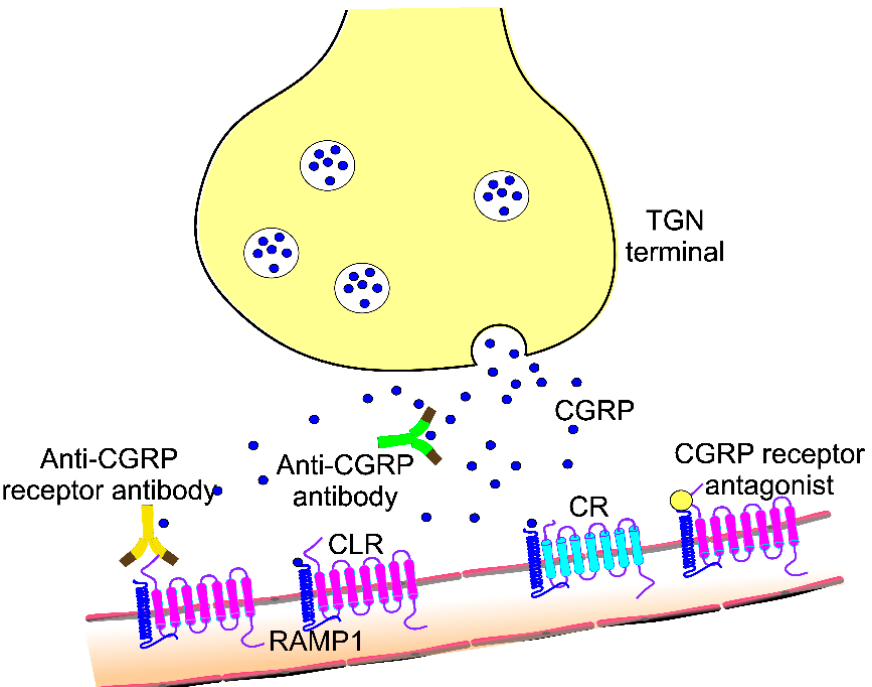
Figure 1. Pharmacodynamics of binding calcitonin gene-related peptide (CGRP) and its receptors by monoclonal antibodies and receptor antagonists (gepants) in the trigeminovasculature. CGRP is released from free endings of trigeminal nerve (TGN) afferents and can be blocked by its antibodies, preventing its binding with receptors and possible internalization, leading to dural vasodilation and neurogenic inflammation and positive feedback leading to peripheral sensitization. CGRP may bind its canonical receptor consisting of a G protein-coupled receptor (not presented here), calcitonin-like receptor (CLR) and an accessory protein, receptor activity-modifying protein 1 (RAMP1). A second receptor, the AMY-1 receptor, consisting of a calcitonin receptor (CR) and RAMP1, may also be targeted by CGRP. Antibodies against the CGRP receptor and its antagonists block CGRP binding. CGRP may cause cerebral vasodilation leading to central sensitization, but the exact mechanism of action antibodies against CGRP and its receptor is poorly known as these antibodies do not appreciably cross the blood-brain barrier.